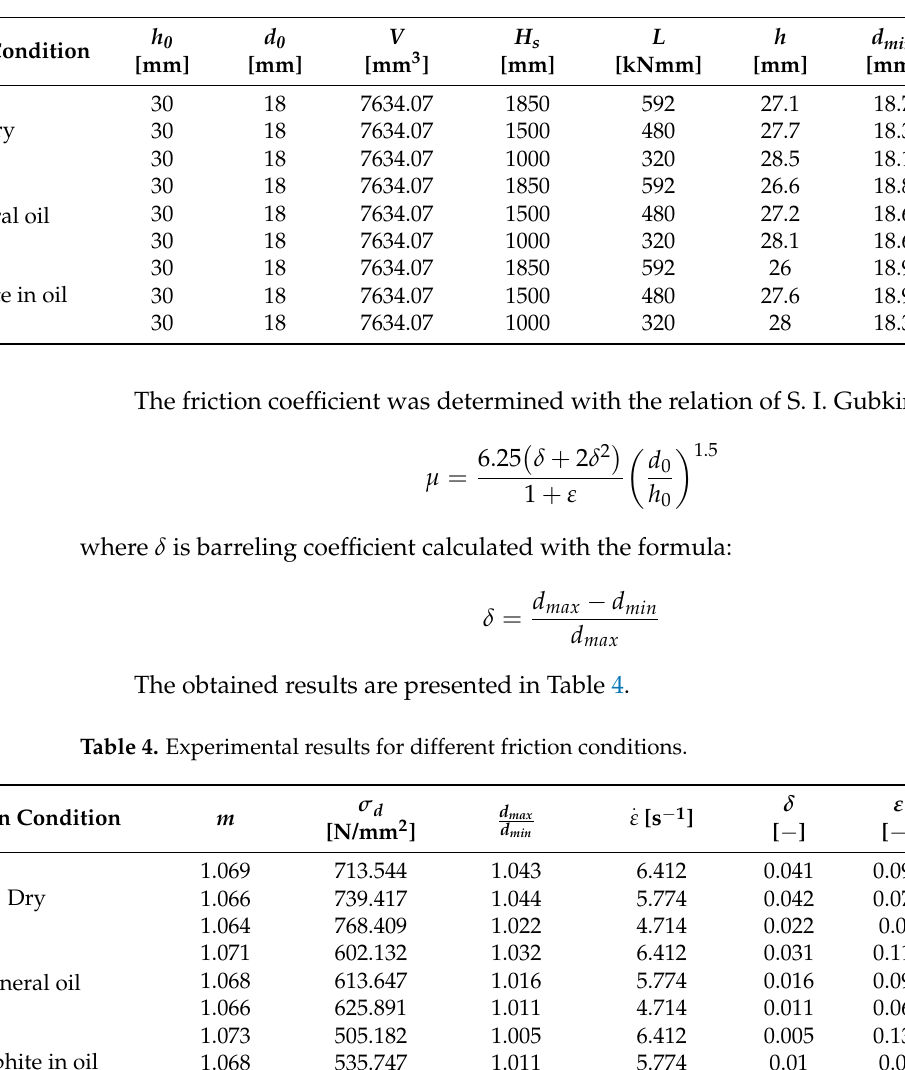
Table 3. Experimental results after hammer deformation.